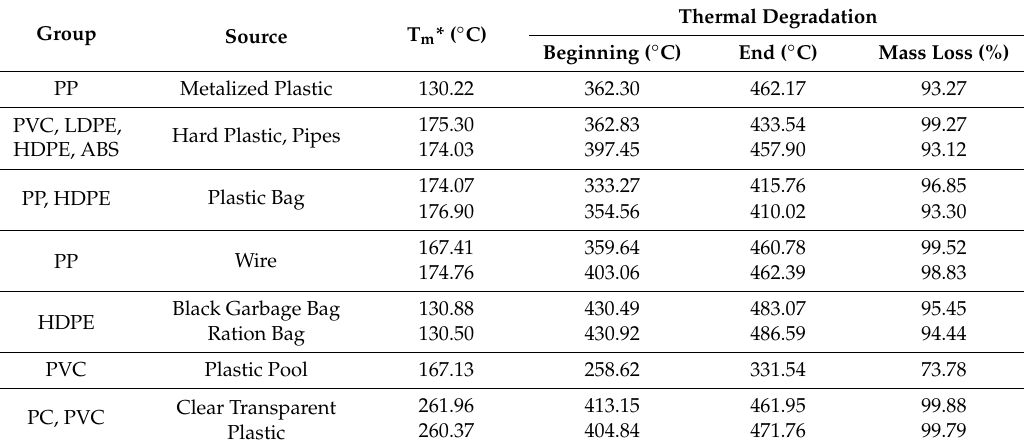
Table 5. Thermal characterization of plastic waste.